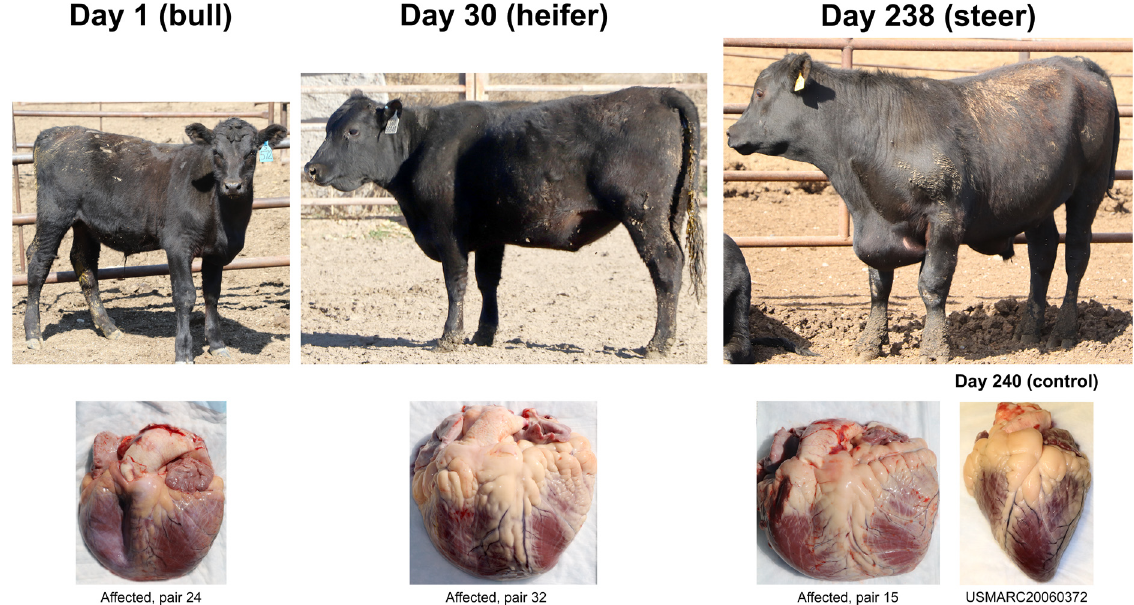
Figure 1. Bovine congestive heart failure (BCHF) clinical cases at different stages of fattening. Three types of animals identified by feedlot pen riders as end-stage heart failure candidates. Clinical cases were born and raised at 1,000 to 1,200 m prior to feedlot arrival. Their respective heart gross morphologies with enlarged right ventricles and pulmonary arteries are shown below each case. The control heart is from an Angus heifer fattened at 550